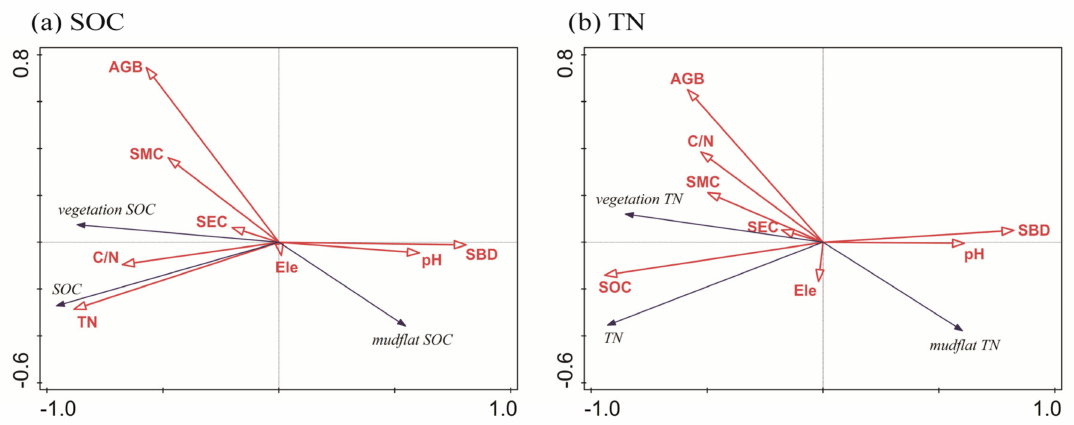
Figure 4. RDA of the relationship between environmental factors and soil organic carbon (SOC) ( a ), and total nitrogen (TN) ( b ) under different land cover types (Note: blue lines indicate the response variables and red lines indicate explanatory variables; SBD = soil bulk density, Ele = elevation, SEC = soil electrical conductivity, SMC = soil moisture content, AGB = aboveground